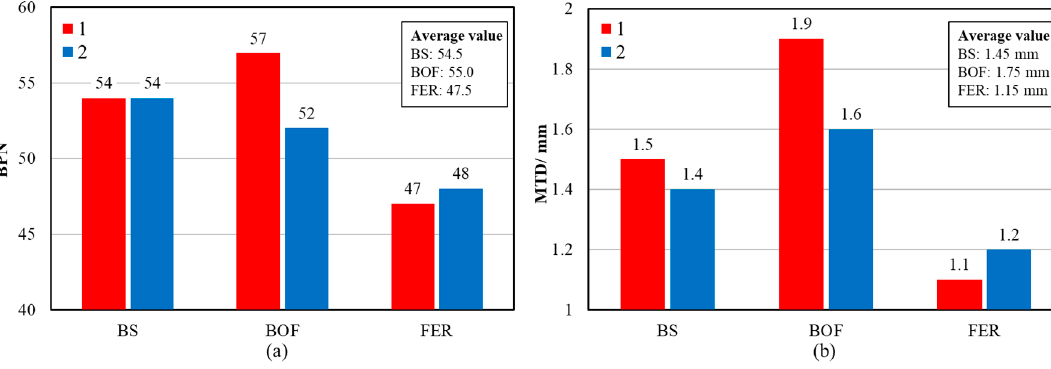
ff erent chip seal samples: ( a ) BPN, ( b ) Figure 10. Surface features of different chip seal samples: ( a ) BPN, ( b ) MTD. Figure 10. Surface features of di Figure 10. Surface features of different chip seal samples: ( a ) BPN, ( b ) MTD. Figure 10. Surface features of different chip seal samples: ( a ) BPN, ( b ) MTD.